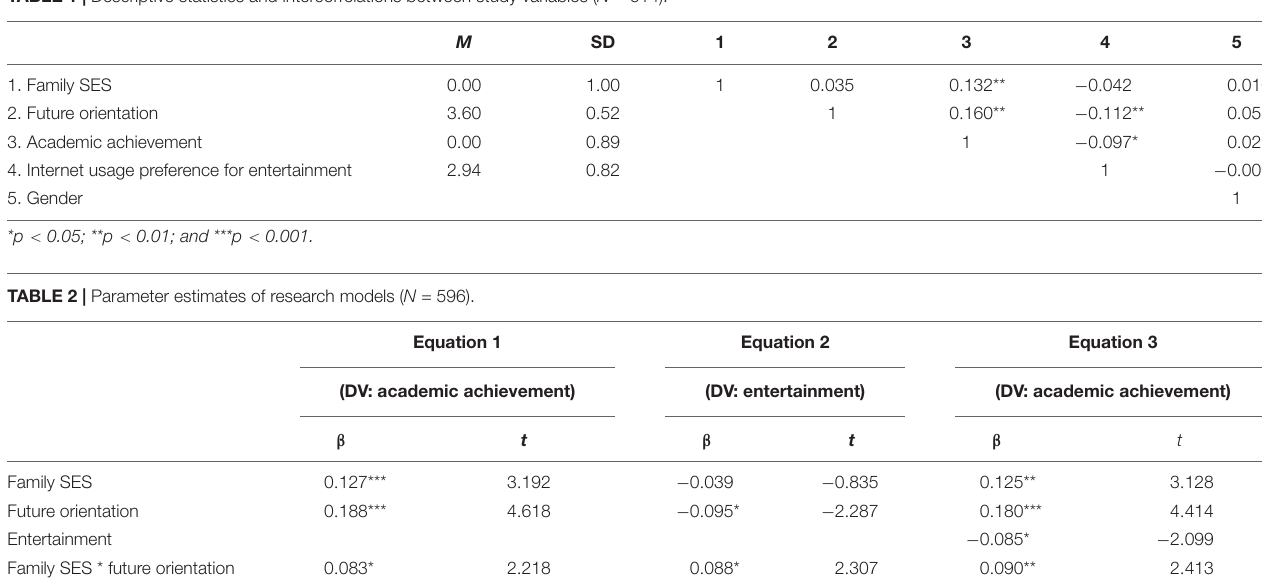
TABLE 1 | Descriptive statistics and intercorrelations between study variables ( N = 614).